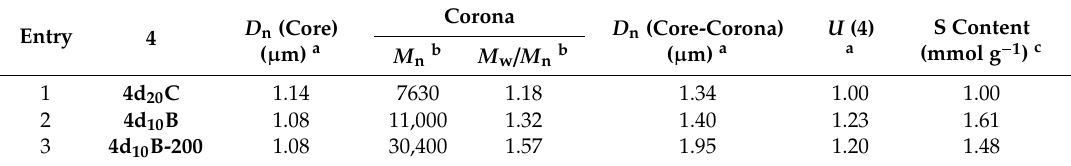
Table 1. Characterization of CCM–SO 3 H 4